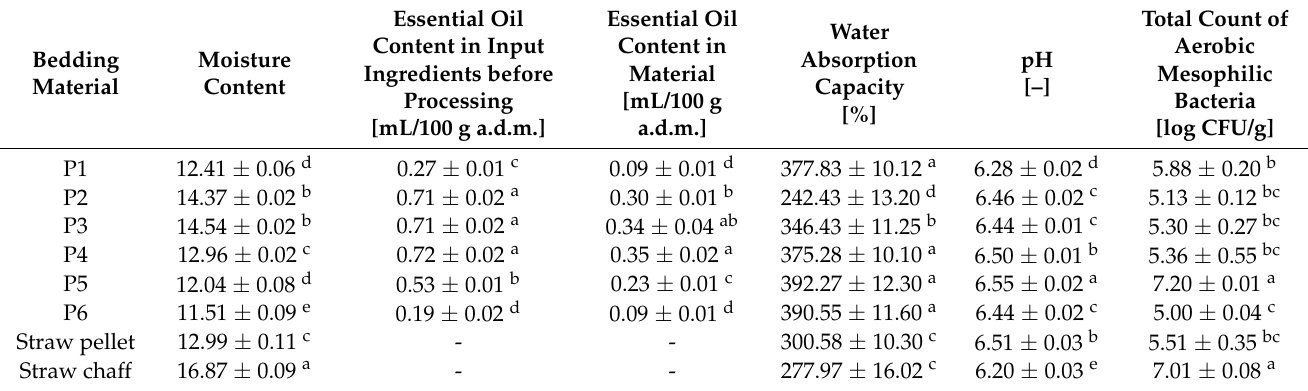
Table 2. Moisture and essential oil content, pH, water absorption capacity and total count of aerobic mesophilic bacteria in the tested bedding materials prior their